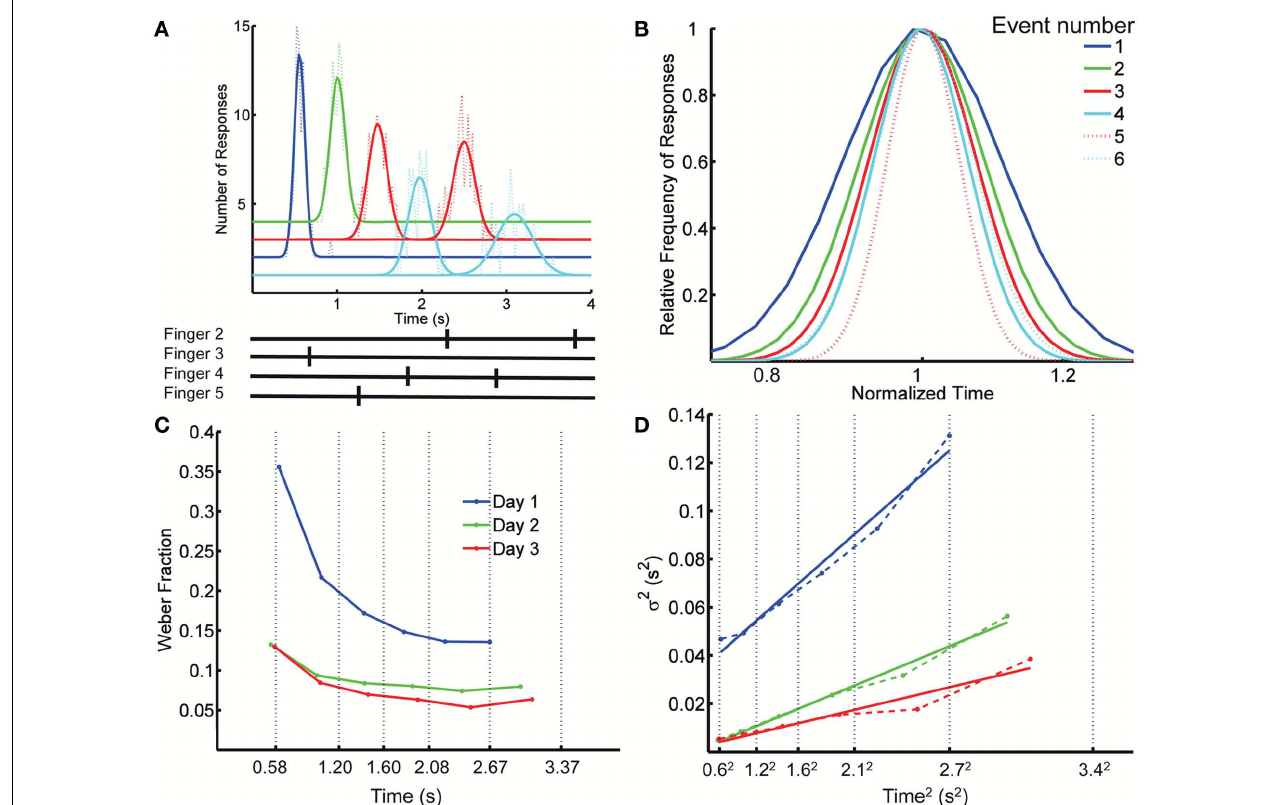
− 230 ± 320ms ( p = 0.03).The spatial error rate (trials with incorrect finger presses) decreased rapidly over the first few blocks: in the first block, on average, 33% of the trials had a spatial error; this fell to 8% in the second block, and 0.9% by the last block (12). (B) Overlaid normalized Gaussian fits from (A) . Each distribution has the x axis divided by its mean and their y values divided by their peak value. Dotted lines correspond to the second response of a given finger. (C) Weber fraction ( = coefficient of variation) as a function of mean response time. Same subject, all 3days.Vertical dotted lines indicate the target times. (D) Variance as a function of mean response time squared (dashed lines), and linear fits according to the generalizedWeber’s law (Eq. 1, solid